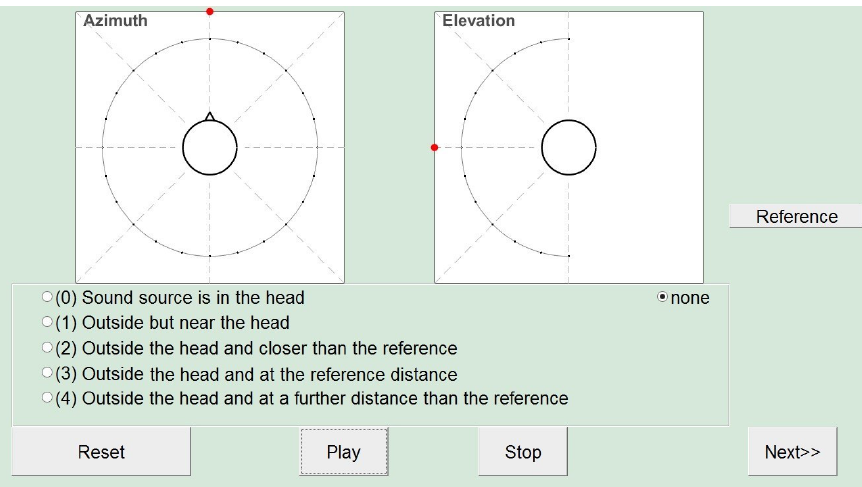
Figure 4. GUI for collecting the responses on source azimuth, elevation and distance. By click- ing the “Reference” button, subjects could switch to the signal coming from the reference source in the room, to give the perceived source distance between 0 (inside the head) and 4 (outside the head and at a further distance than the reference). The “Reset” button was active only during TestVR and was used to reset the head tracker. The frontal direction of azimuth = 0 ◦ and elevation = 0 ◦ , corresponding to the forward head orientation, was marked with a colored point on the